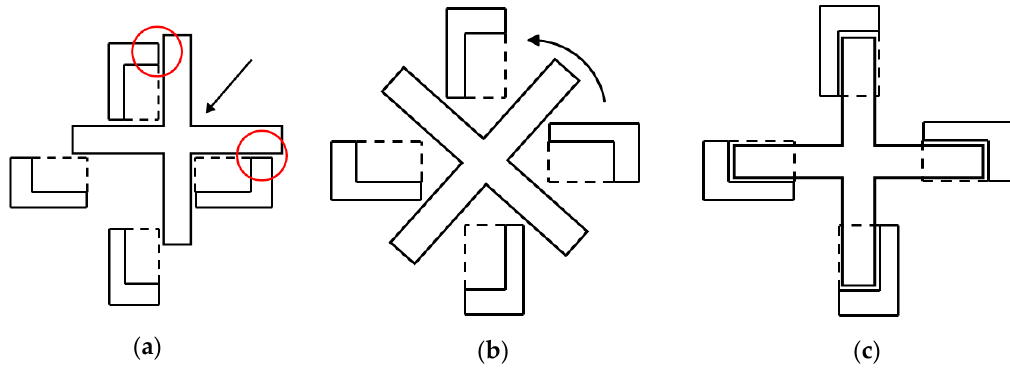
Figure 9. Illustration of the placement of a cruciform specimen: ( a ) typical configuration; ( b ) adopted configuration; ( c ) cruciform specimen ready for testing (no scale).